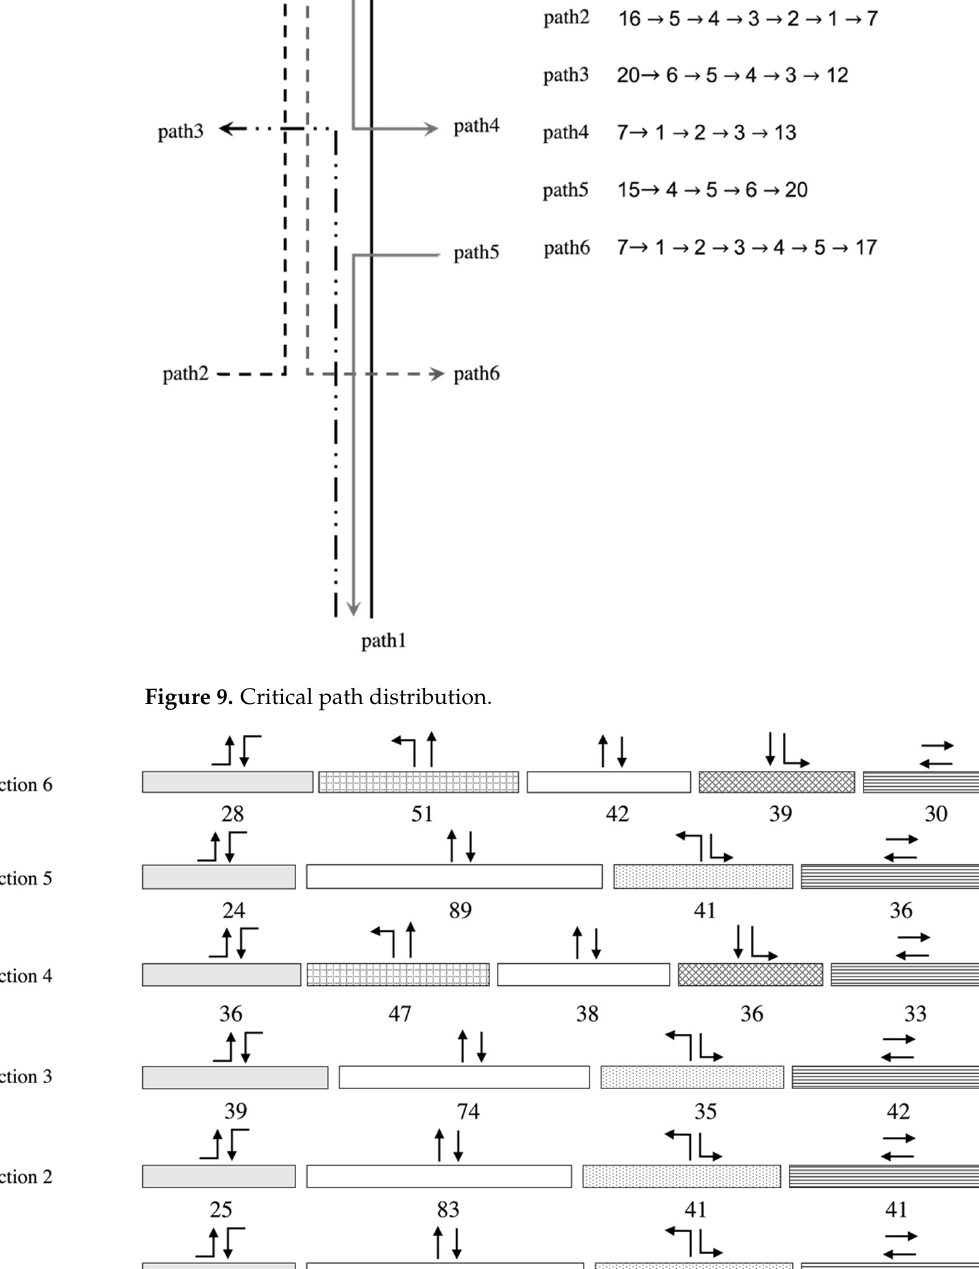
Figure 10. Intersection signal scheme.